Question: Write the caption for this figure.
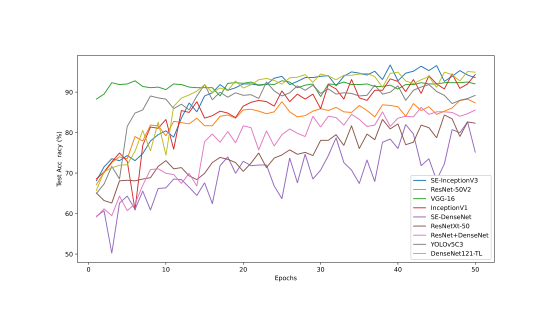
Answer: Comparison of the Accuracy of validation